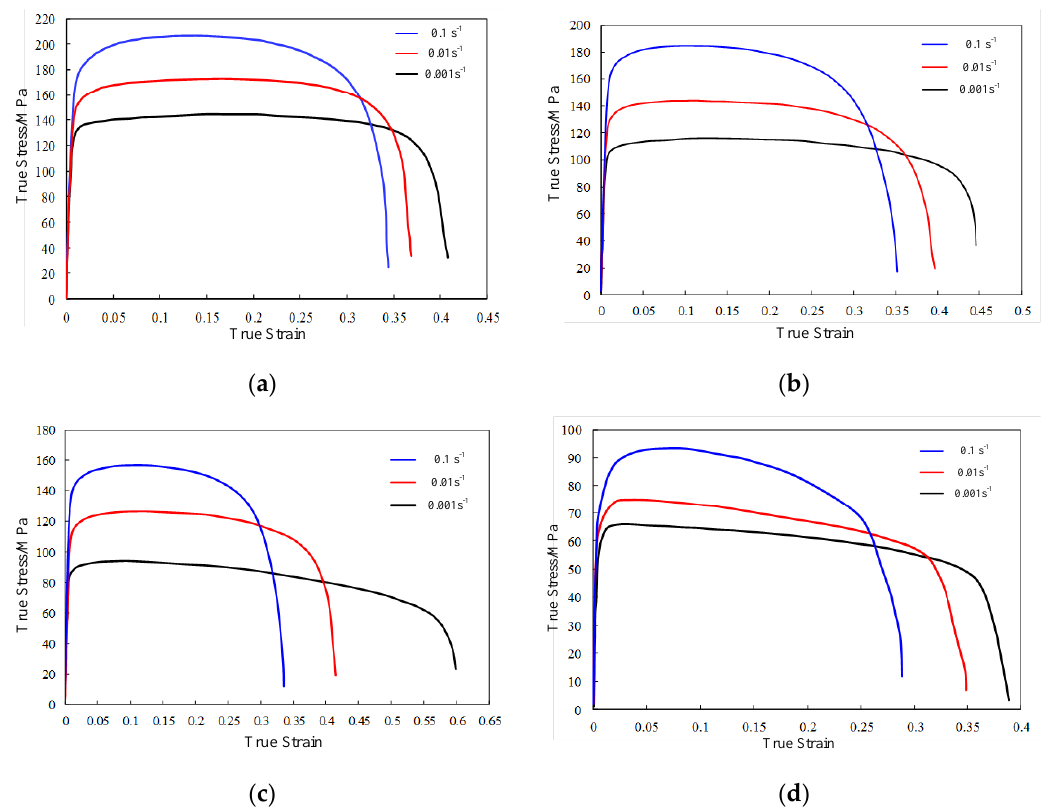
Figure 8. True stress-strain curves for ZK60 magnesium alloy deformed at different temperatures and strain rates: ( a ) 175 °C; ( b ) 200 °C; ( c ) 225 °C; ( d ) 250 °C.